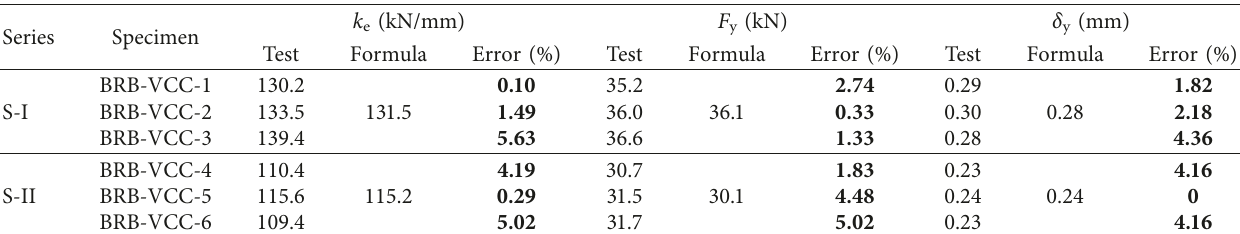
Table 4: Comparison of theoretical and test